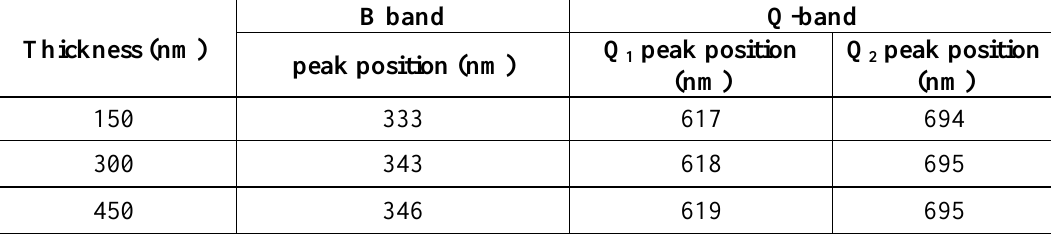
Table 1: Values of maximum absorption peaks for CuPc thin films with various thicknesses.